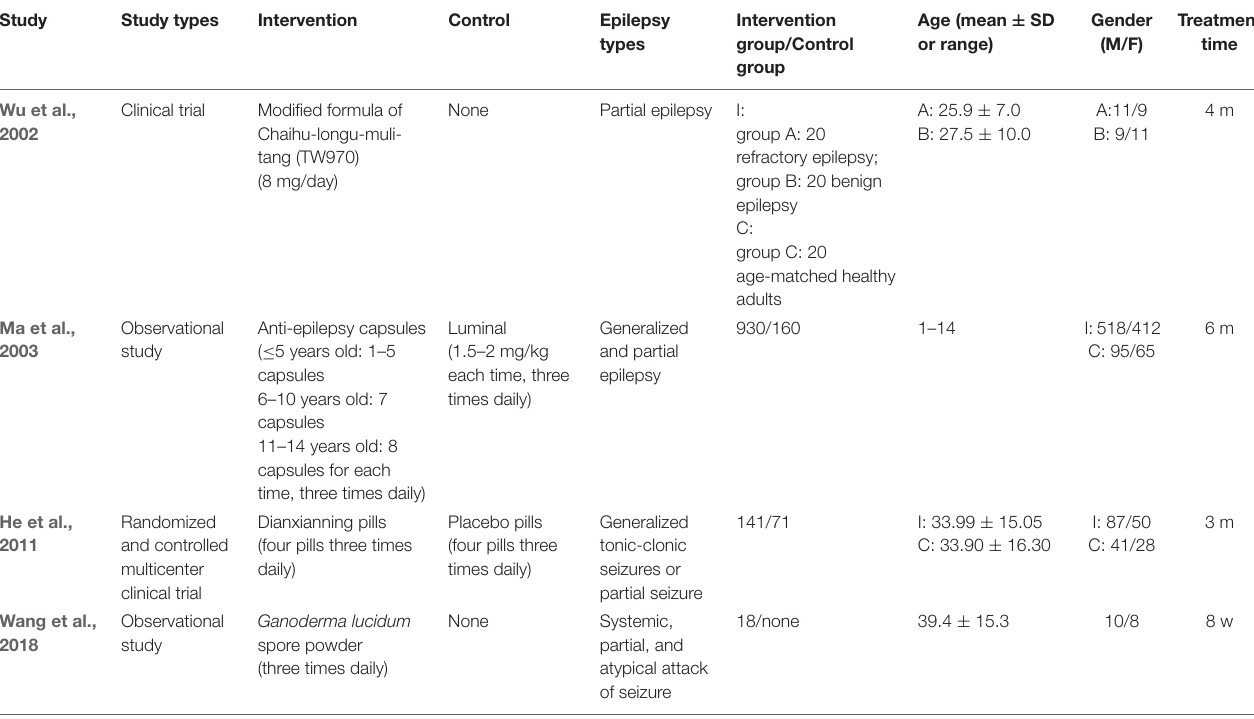
TABLE 2 | Characteristics of human clinical